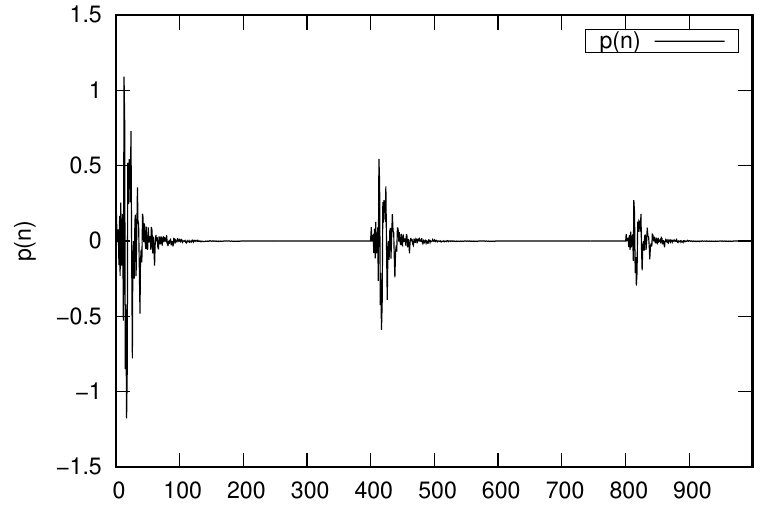
Figure 7. Primary path impulse response used in test case